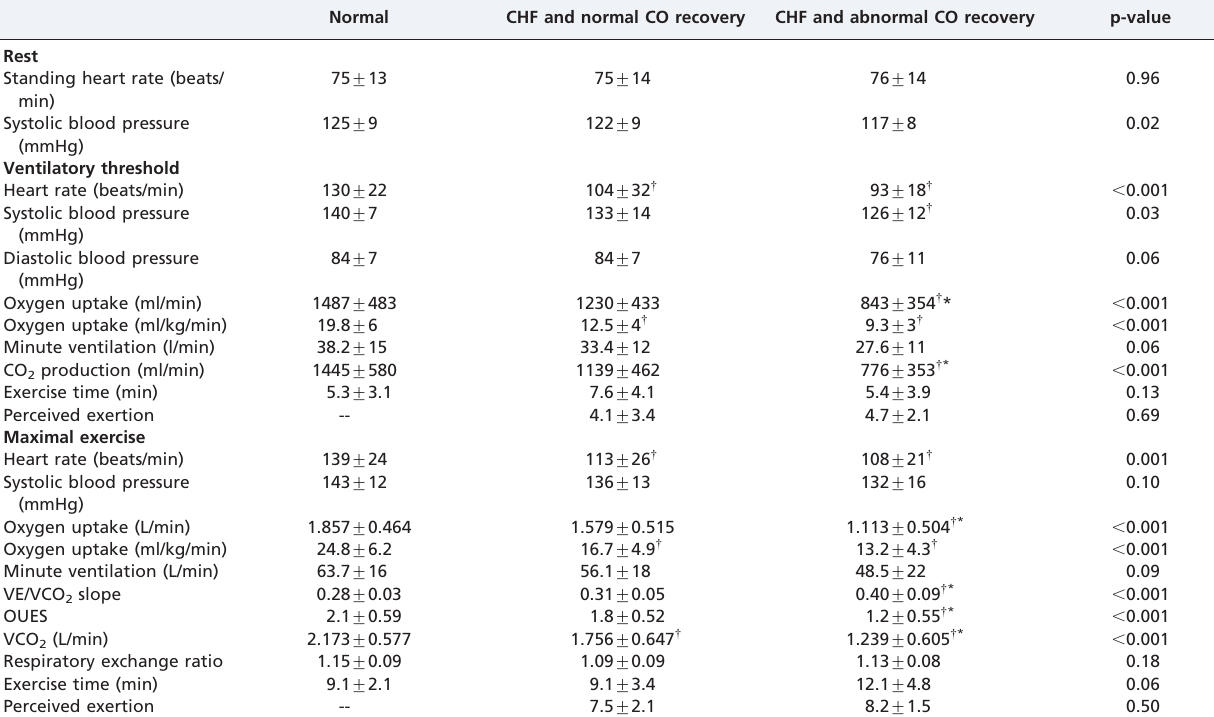
Table 2 - Exercise test responses in normal subjects and CHF patients with normal and abnormal cardiac output in recovery (mean ¡ SD).